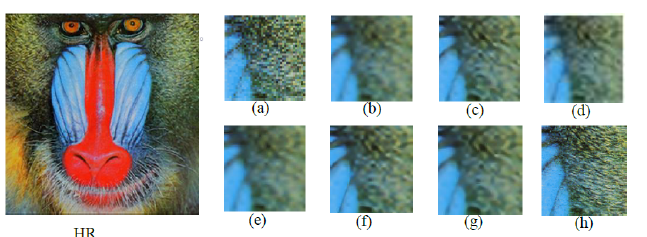
Figure 3. Qualitative comparison between our EMTCM and state-of-the-art SR models with the scale factor 3. ( a ) HR ( b ) Bicubic ( c ) FSRCNN ( d ) LapSRN ( e ) VDSR ( f ) RDN ( g ) SRFRN ( h ) Ours. Best viewed zoomed in.